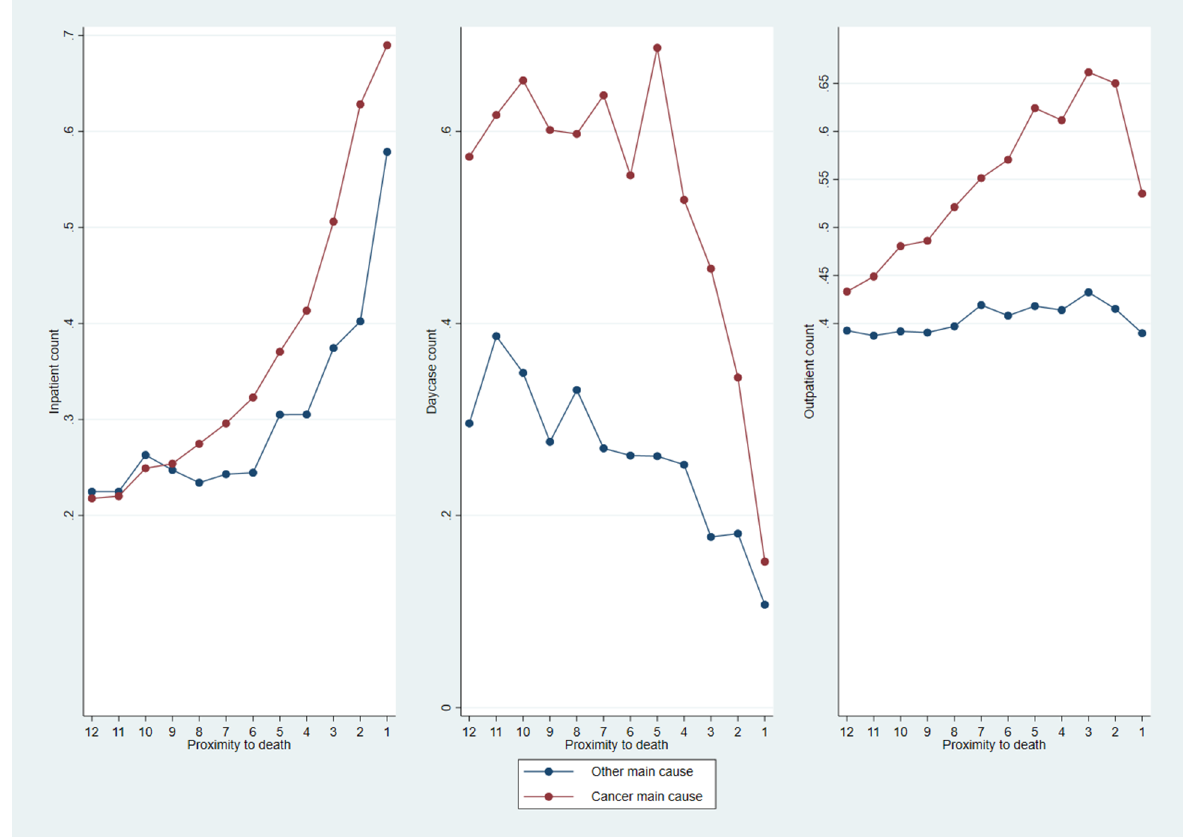
Supplementary Figure 3: Inpatient, day case and outpatient resource use patterns in cancer- patients’ last 12 months of life. Proximity to death (in month) on the x-axis; average resource use within each month on the y-axis. Results are presented for cancer patients with and without cancer as main cause of